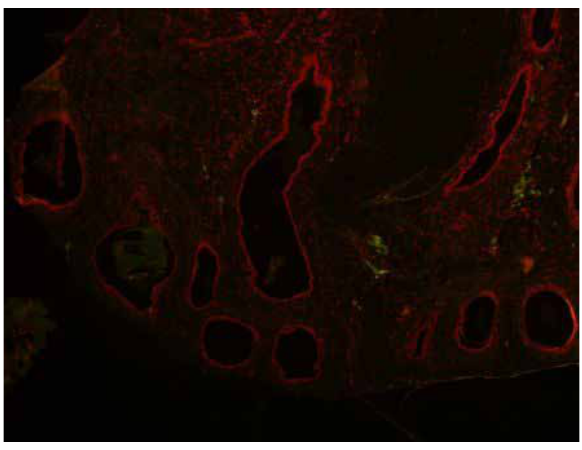
figure 3 - Group III. Microscopic fluorescence immunohisto- chemistry for the detection of active caspase-3. Increase